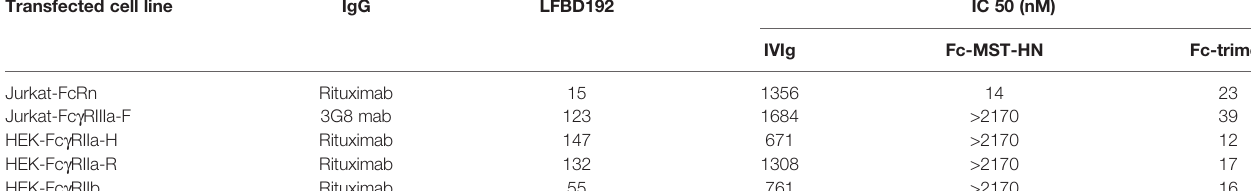
TABLE 3 | Determination of inhibitory concentration at 50% (IC 50) between IgG1 and LFBD192, IVIg, Fc-MST-HN, and Fc-trimer on cell lines transfected with hFcRn or hFcRs (IC50 calculated with mean of 2 experiments). Transfected cell